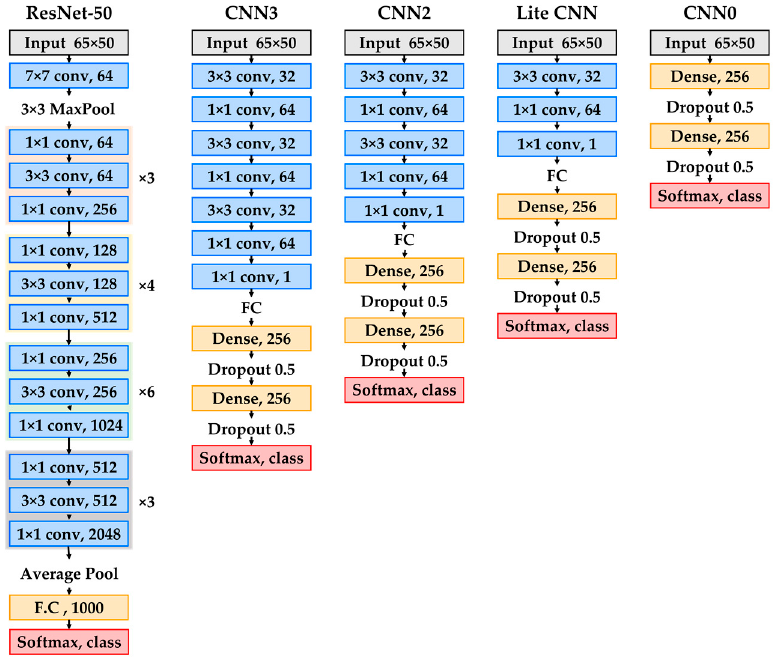
Figure 9. Proposed model (lite CNN) and comparison models (ResNet50, CNN3, CNN2, and CNN0).